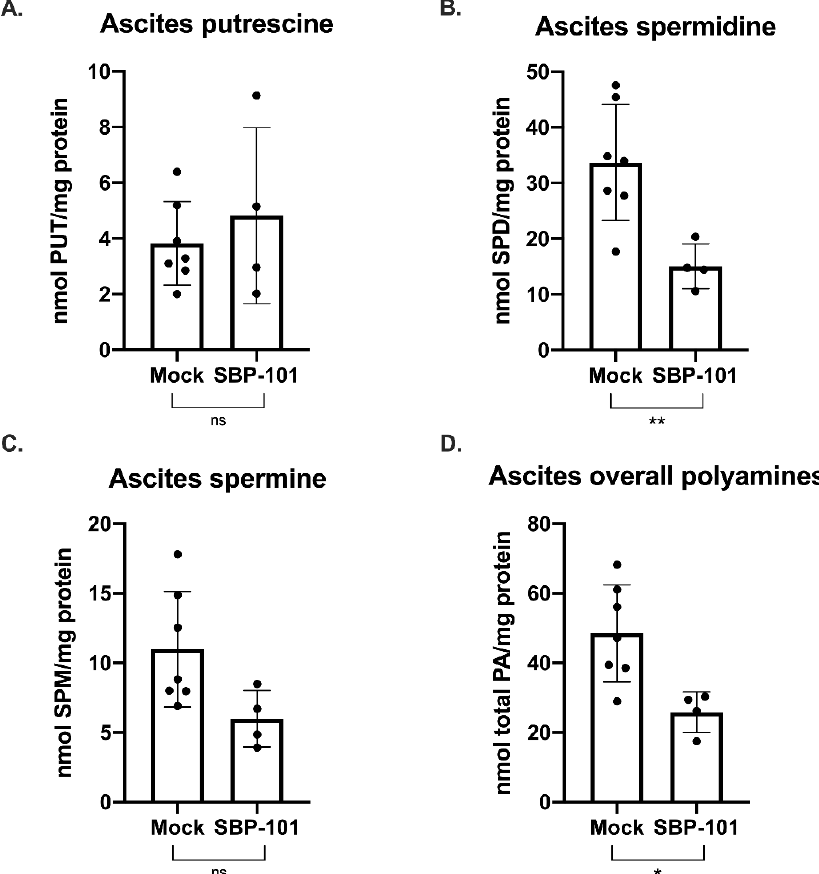
Figure 6. SBP-101 results in decreased polyamine content in the cells of the ascites fluid of treated mice. Ascites was drained from a subset of untreated mice and mice treated with 24 mg/kg SBP-101 (3× alternating weeks) 52 days post-VDID8 + injection. Red blood cells were lysed from drained as- cites fluid, and the remaining cells were analyzed for polyamine content by HPLC. There was no significant difference in putrescine levels between treated and untreated mice ( A ). Spermidine levels in the ascites cells were significantly decreased in SBP-101-treated mice with a p -value of 0.008 ( B ). Spermine levels were also lower in the ascites cells of treated mice, though the observed decrease was not statistically significant ( p -value = 0.0534) ( C ). Overall polyamine levels were significantly lower in SBP-101-treated mice ( p -value = 0.014) ( D ). Significance symbols are as follows: ns = not significant (p-value > 0.05); * = p-value < 0.05; ** = p-value < 0.01. 3. Discussion Cancer cells depend on an aberrant polyamine metabolism to maintain the elevated polyamine levels required for continual self-renewal [5,26]. Many attempts have been made at enzymatic inhibitors; however, the difficulties associated with monotherapeutic enzyme inhibition have led to an expanded interest in compounds that further regulate polyamine metabolism. Polyamine analogues are molecules structurally similar to the na- tive polyamines that are recognized and transported by the polyamine transport system